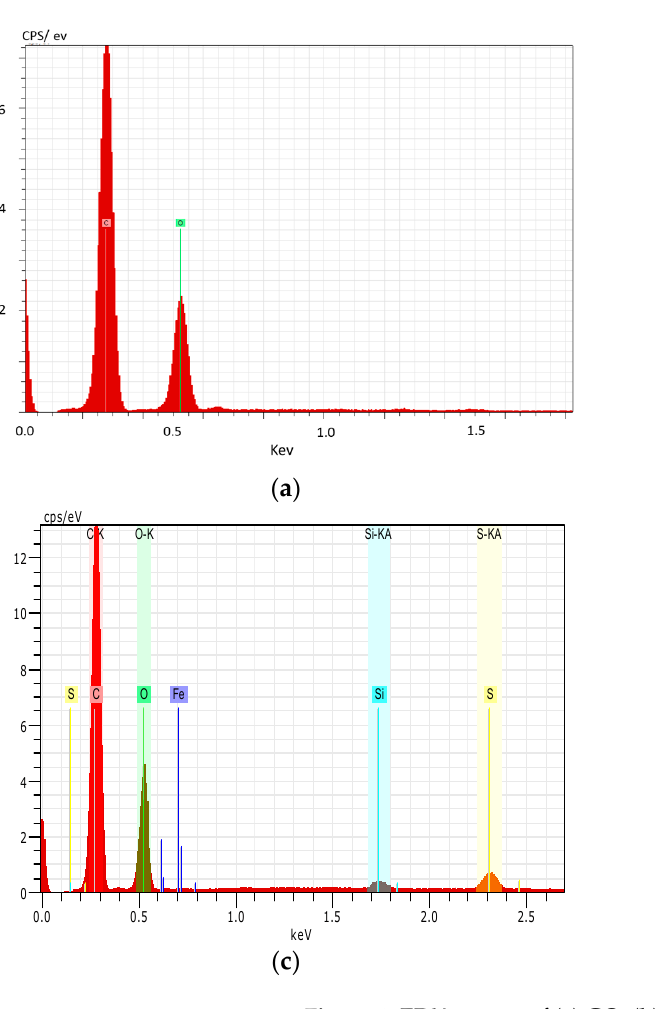
( b ) Figure 5. Raman spectrum of ( a ) GO and ( b ) RGO. By calculating the D to G intensity ratio (ID/IG), it is found to be 1.27 in GO, which after reduction gives the value of RGO (1.16), thereby suggesting that GO is converted to RGO. Additionally, all D peaks were changed after the reduction treatment. These